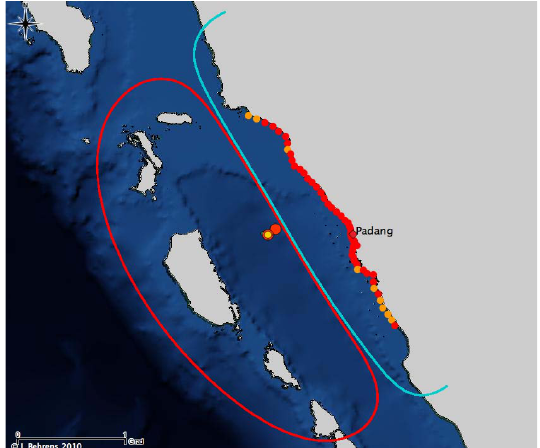
Fig. 15. Result of the selection after 3.6min (data set 2), analogous to Fig. 14. The selected scenario corresponds to a magnitude 8.5 ( M w ) earthquake, largely over-estimating the true event.